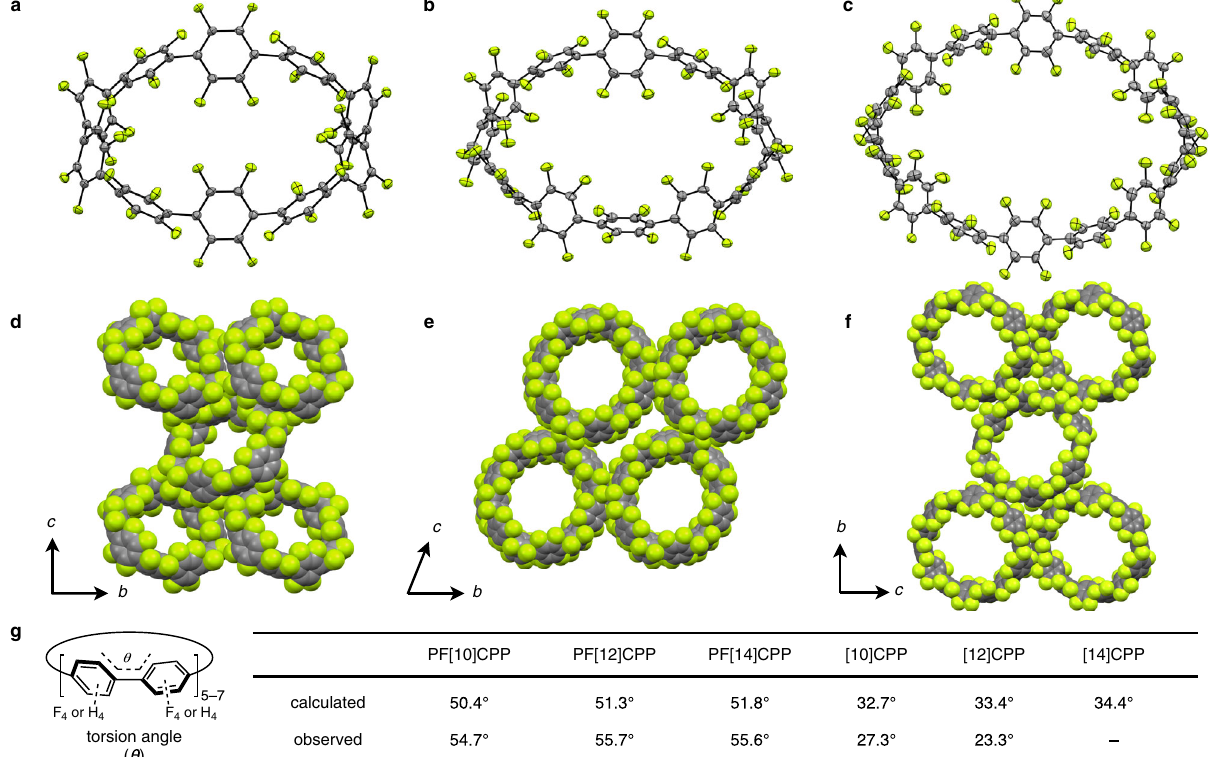
Fig. 3 X-ray crystal structures of PF[n]CPPs ( n = 10, 12, 14). a , b , c Structures of PF[10]CPP ( a ), PF[12]CPP ( b ), and PF[14]CPP ( c ) with thermal ellipsoids at 50% probability. Solvent molecules are omitted for clarity. d , e , f Packing structures of PF[10]CPP ( d ), PF[12]CPP ( e ) and PF[14]CPP ( f ); gray: carbon; green: fl uorine. Solvent molecules are omitted for clarity. g The dihedral angles ( θ ) around the C – C single bonds of PFCPPs and corresponding CPPs 31, 32 . Calculations were performed at the B3LYP/6-31G(d) level of theory. Dihedral angles obtained from X-ray crystallography are